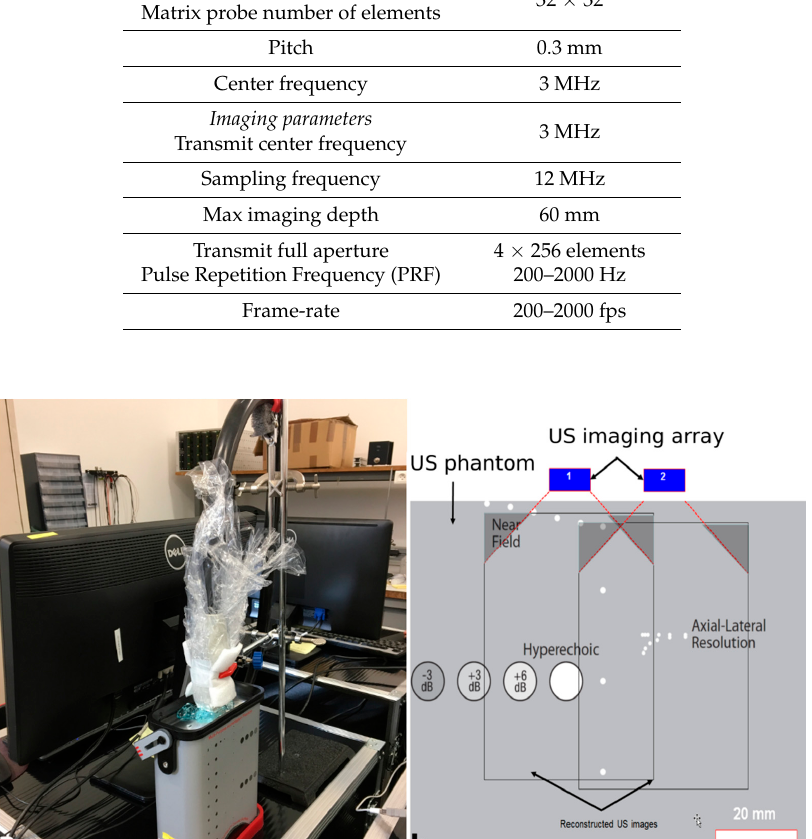
Table 1. US acquisition parameters.